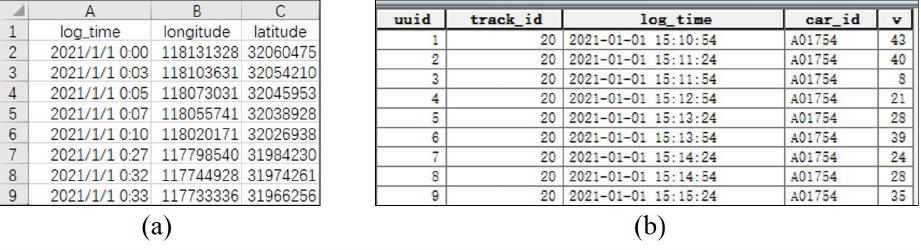
Figure 2. Trajectory data pre-processing: ( a ) raw trajectory data; ( b ) pre-processed trajectory